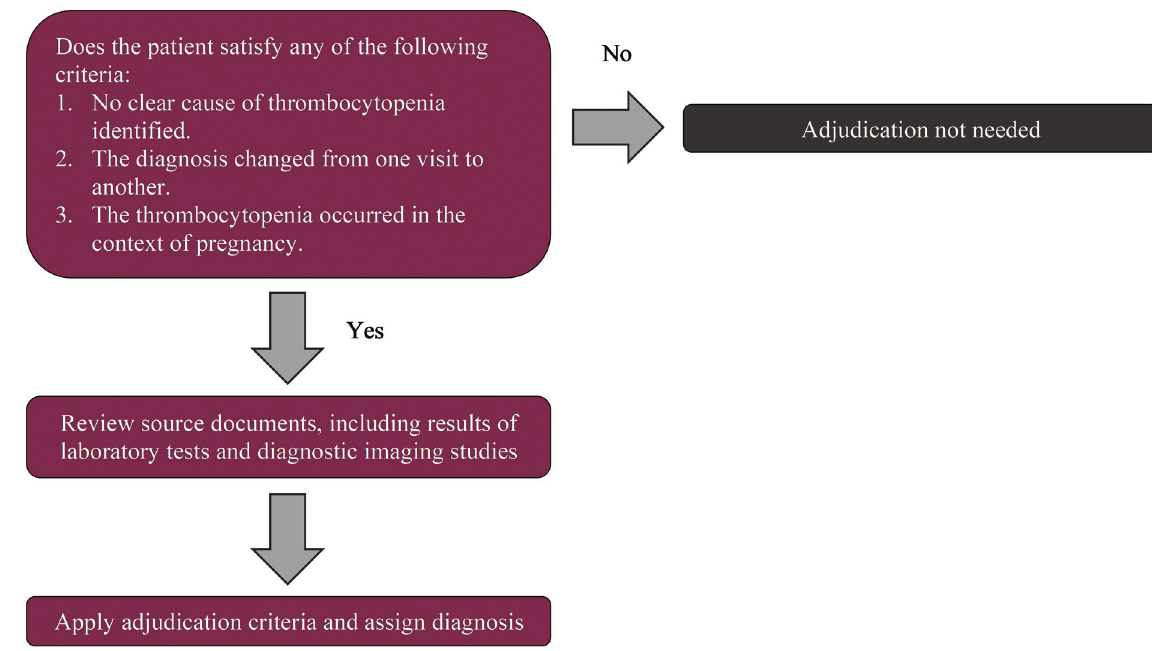
Fig. 1 Flowchart demonstrating the application of the adjudication process for patients with thrombocytopenia in a research context.